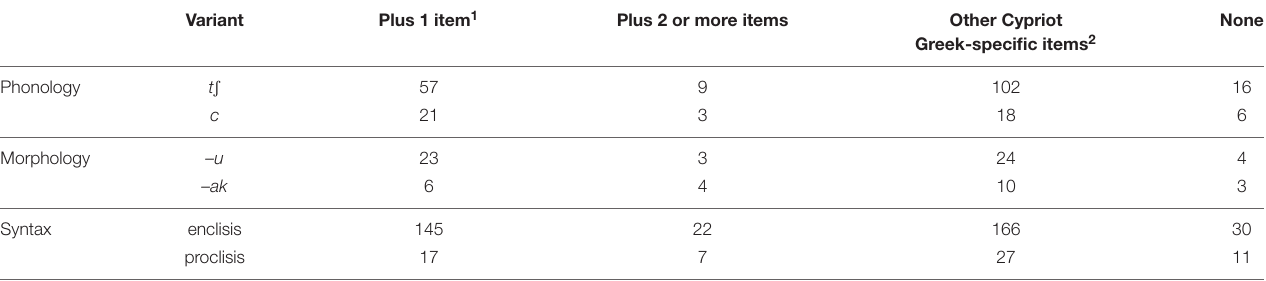
TABLE 3 | Production of multiple Cypriot Greek-specific variants within the same